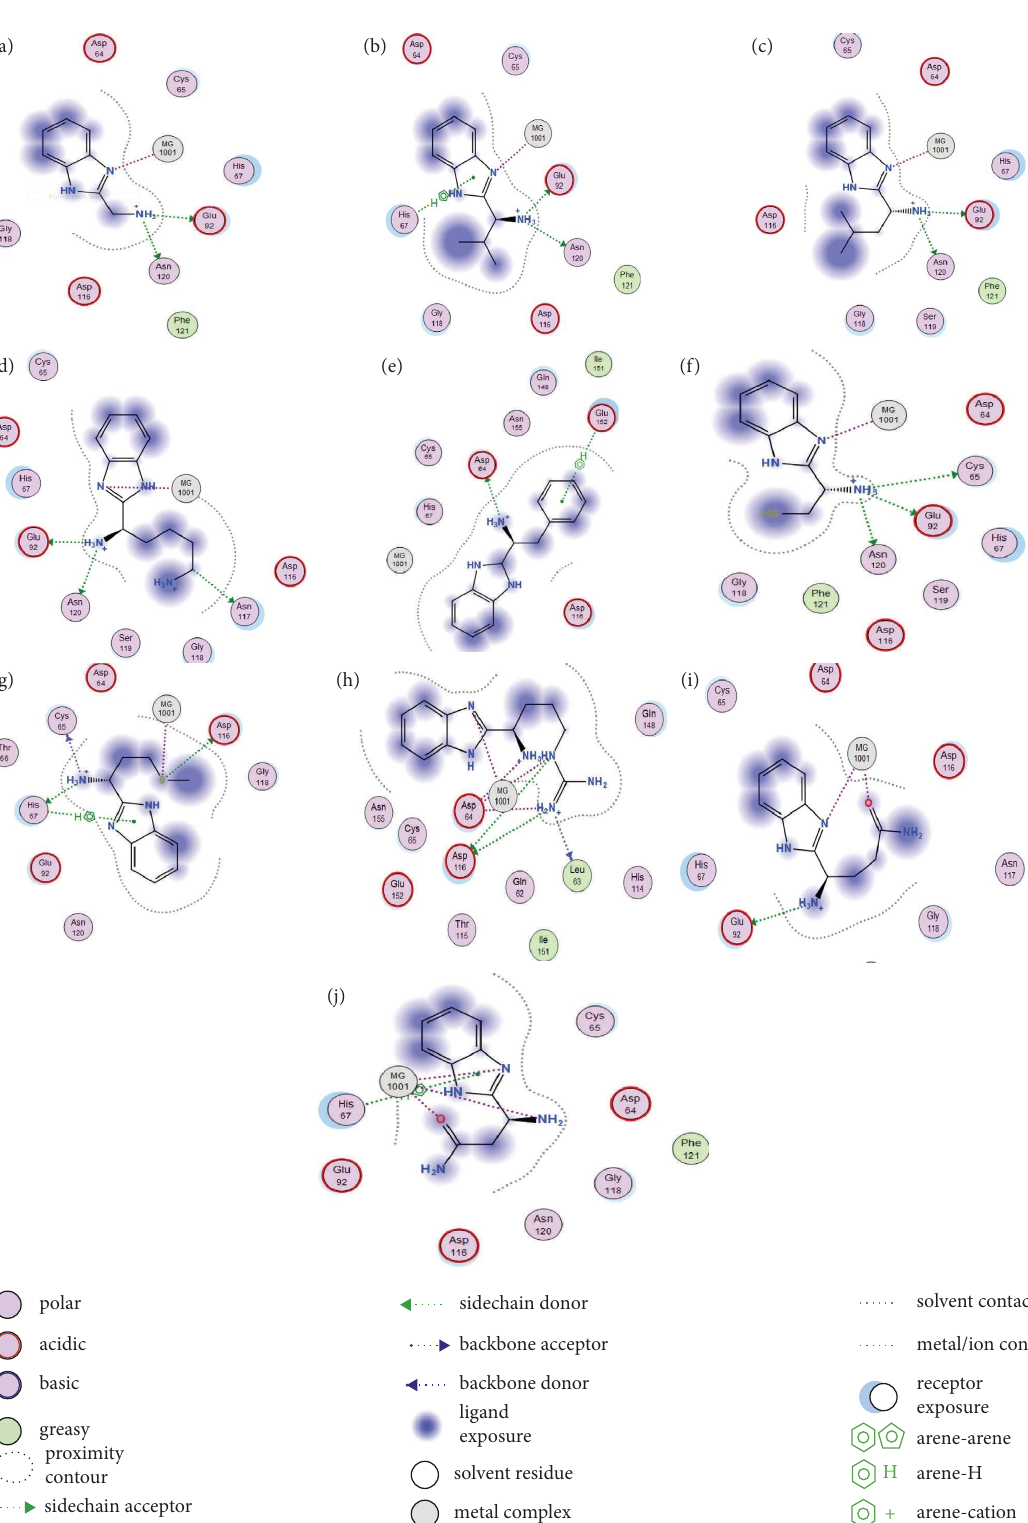
Figure 4: 2D representation of the interaction of HIV-1 integrase CCD dimer with compounds. (a) Compound (a). (b) Compound (b). (c) Compound (c). (d) Compound (d). (e) Compound (e). (f) Compound (f). (g) Compound (g). (h) Compound (h). (i) Compound (i). (j) Compound